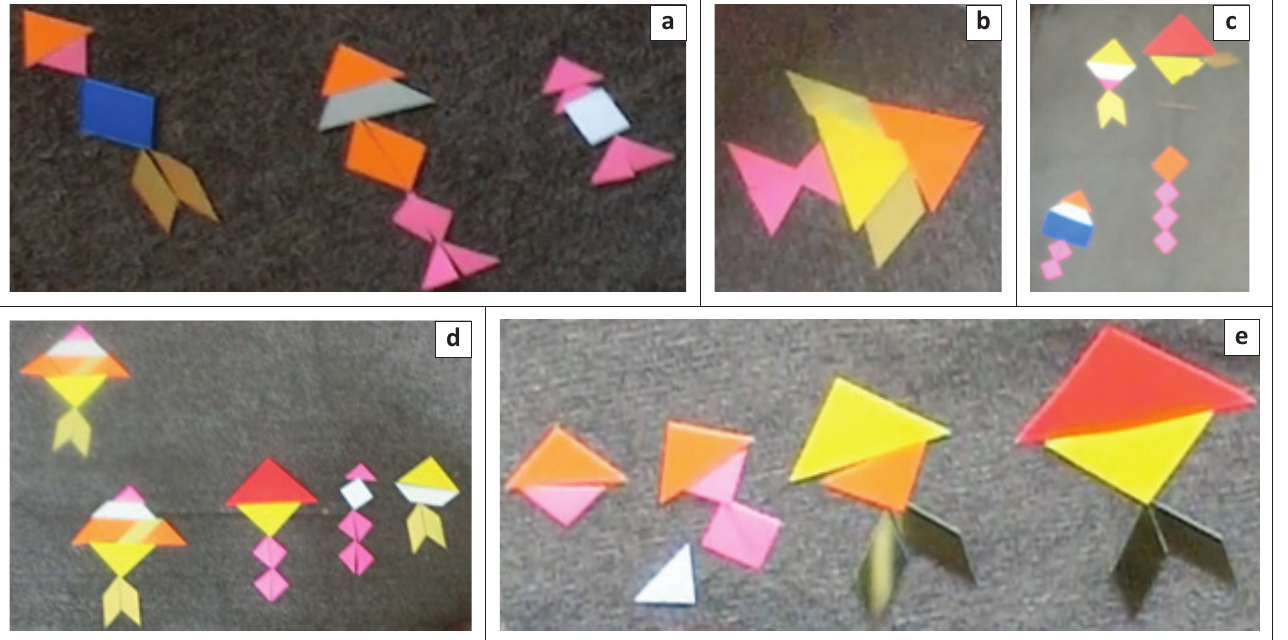
FIGURE 3: Fish with different patterns and shapes made by children in the first